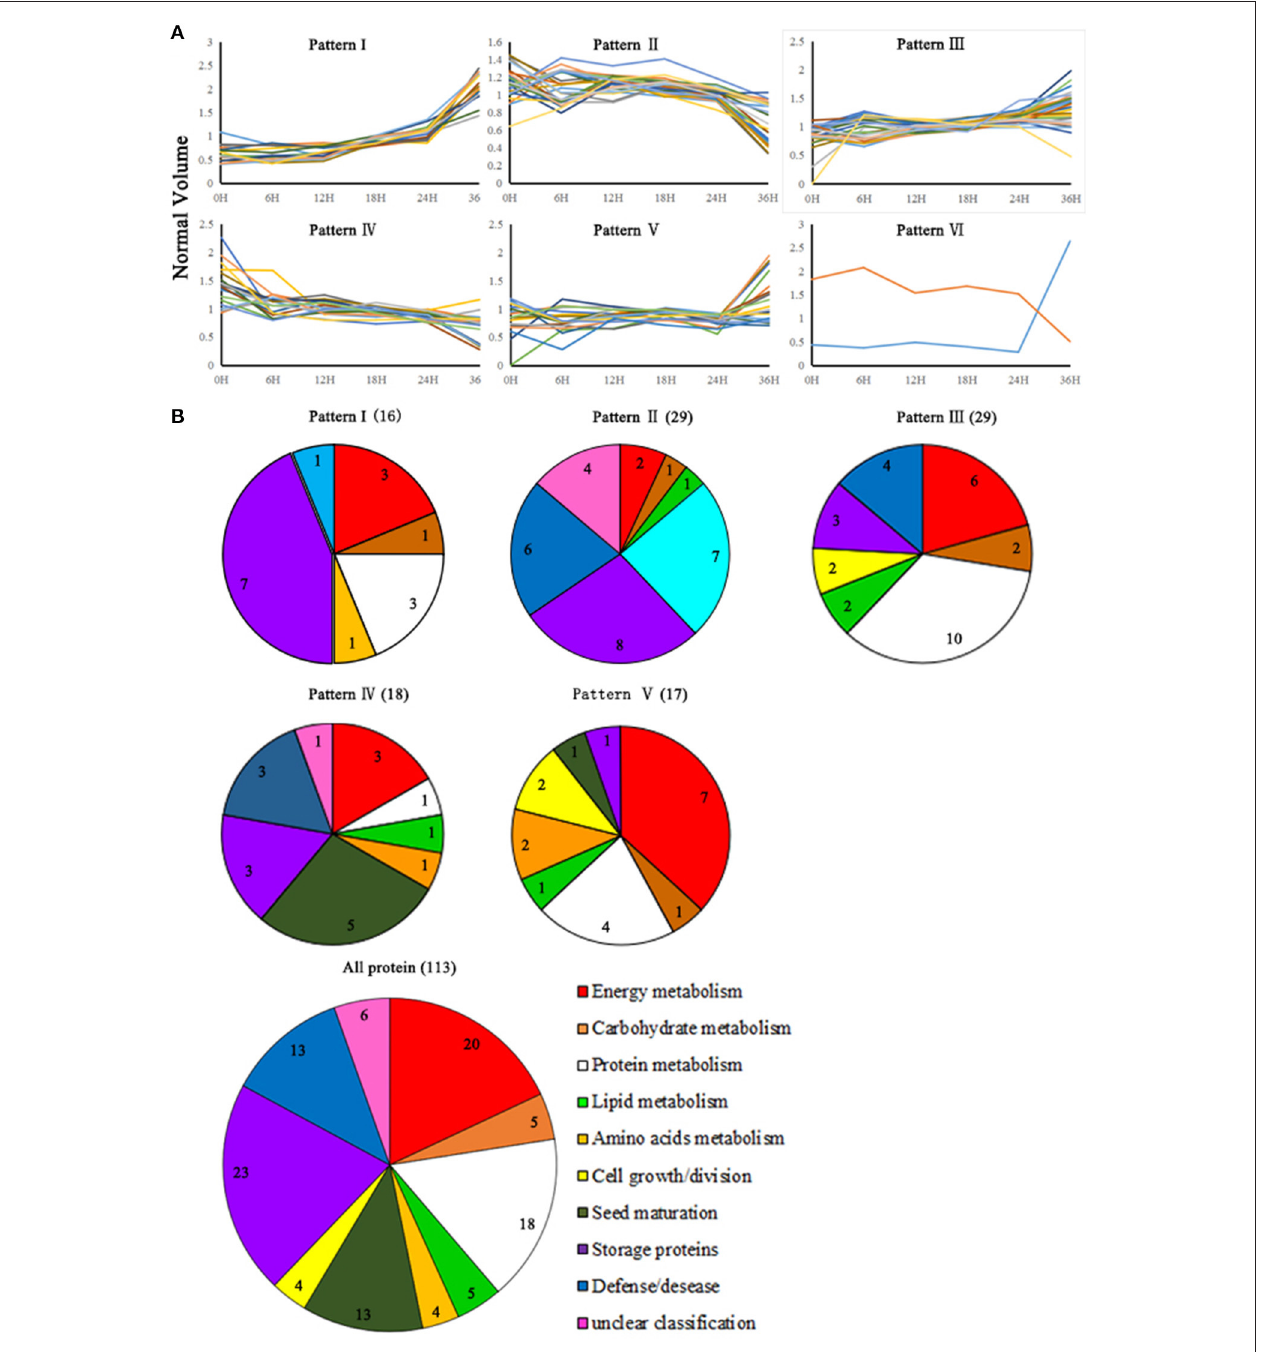
FIGURE 4 | Functional categorization and kinetic patterns of accumulation of DEPs detected in the germination process. (A) The kinetic patterns of accumulation of DEPs. Patterns I–V represents different accumulation patterns groups. (B) The functional categorization of DEPs. Patterns I–V correspond to the functional categorization of the DEPs in different accumulation patterns groups. All protein represents the functional categorization of all DEPs.